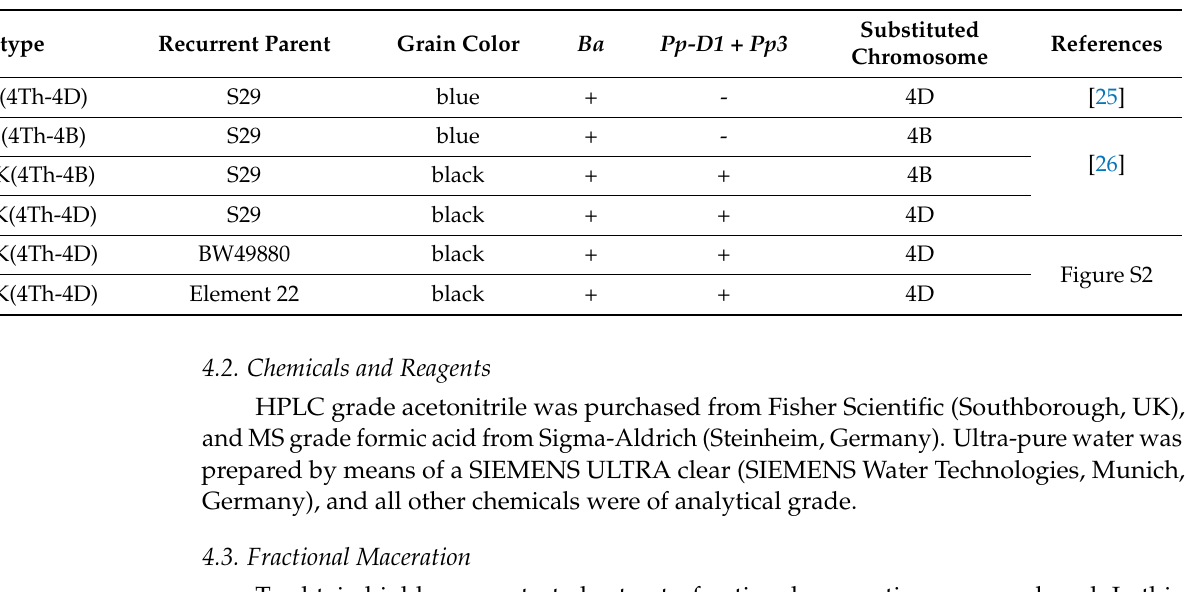
Table 3. Genetic characteristics of the wheat lines used in this study.